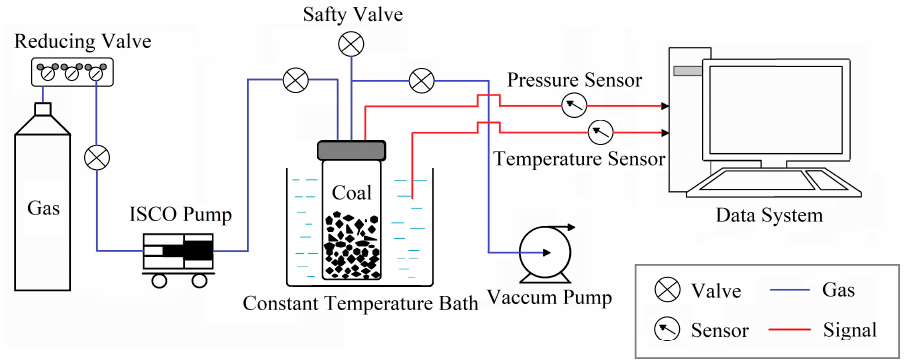
Figure 2. Schematic diagram of coal–ScCO 2 interaction system.